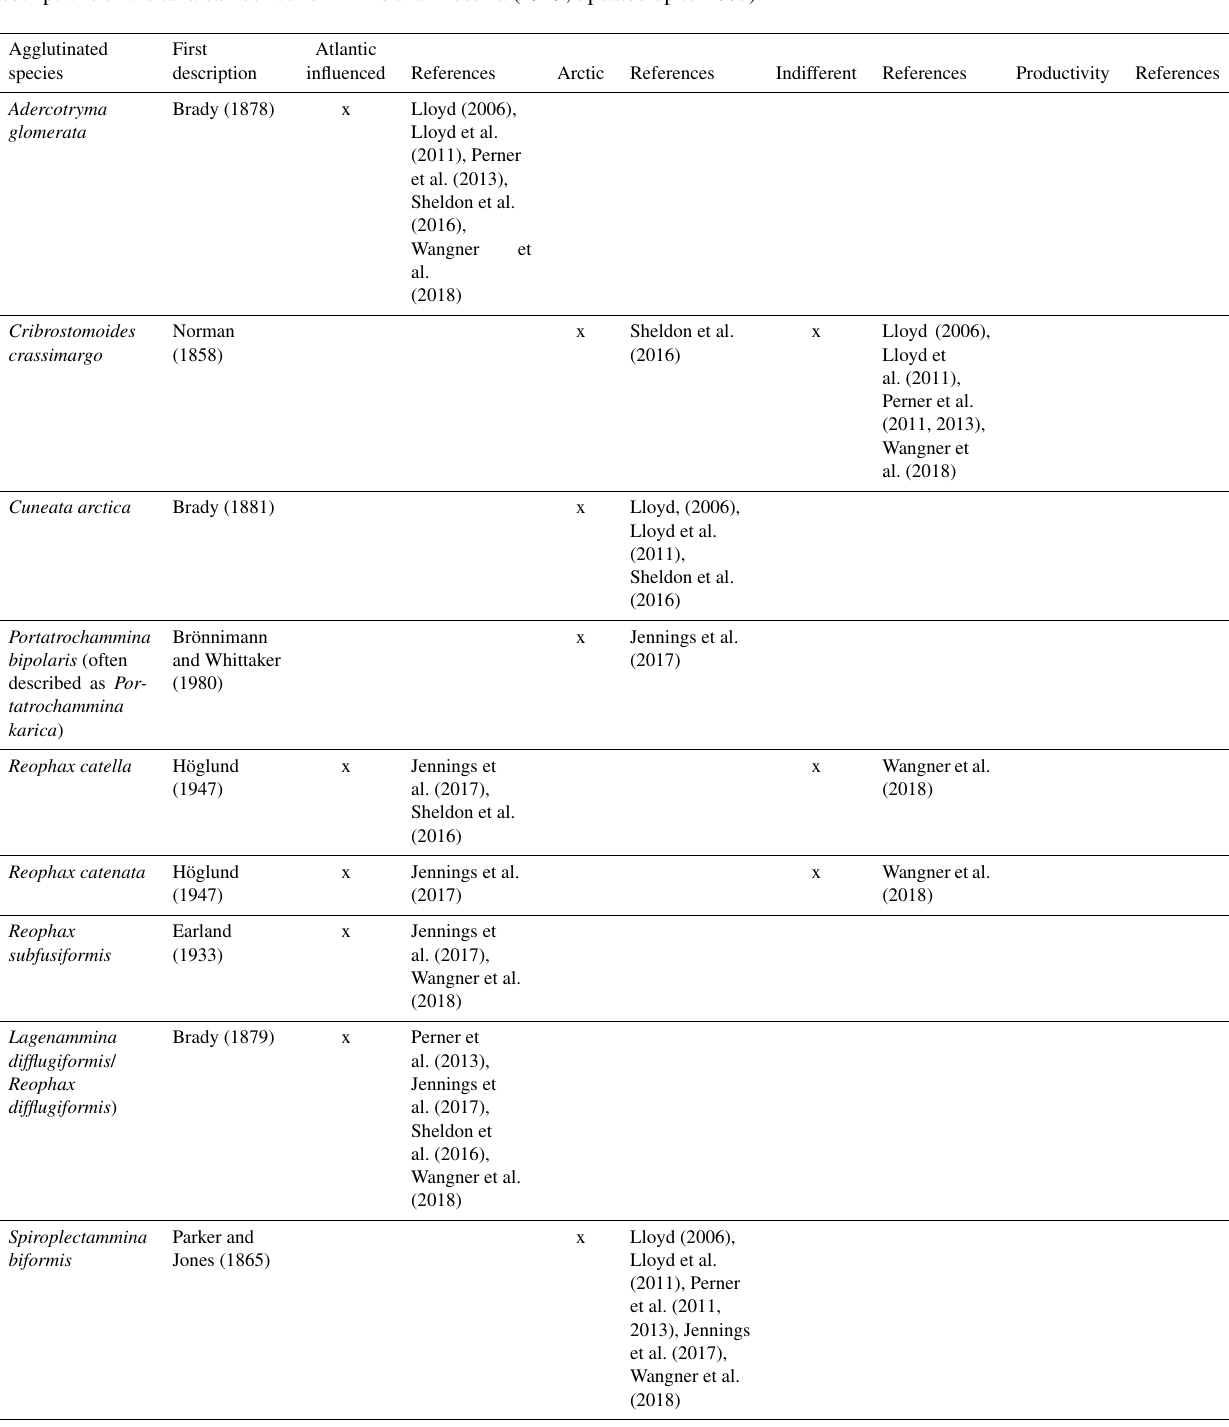
Table 1. Overview of environmental preferences of the benthic foraminiferal species identified in this study. The original references and descriptions of the taxa can be found in Ellis and Messina (1949, updated up to